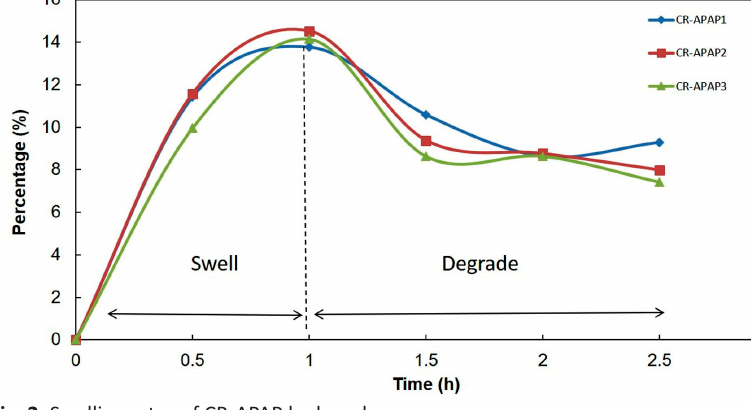
Fig. 2. Swelling rates of CR-APAP hydrogels